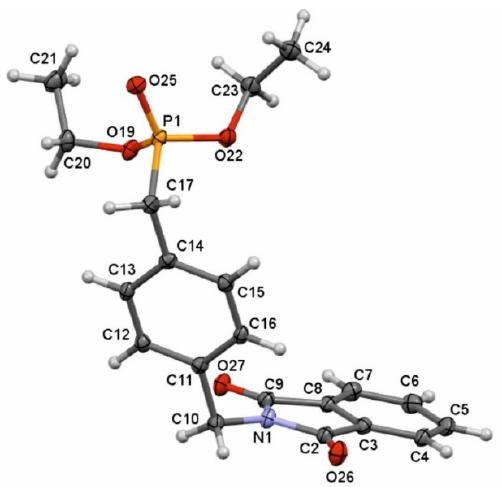
Figure 4. Molecular structure of 7c with atom-labeling scheme.